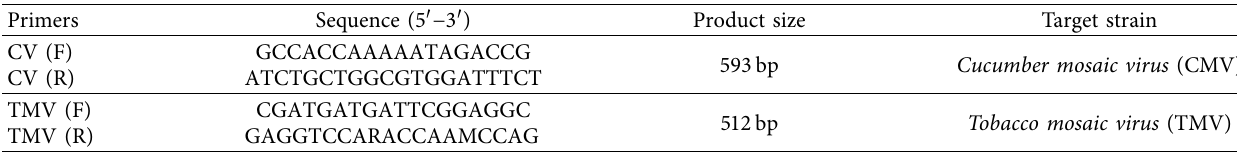
Table 1: Nucleotide sequences of oligonucleotide primers used for molecular testing, genomic locations, and target viruses in African nightshades.